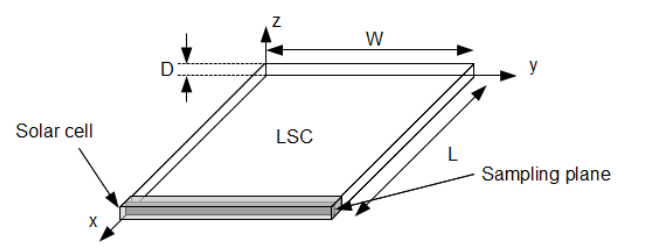
Figure 3. Dimensions of the LSC used in the ray-tracing